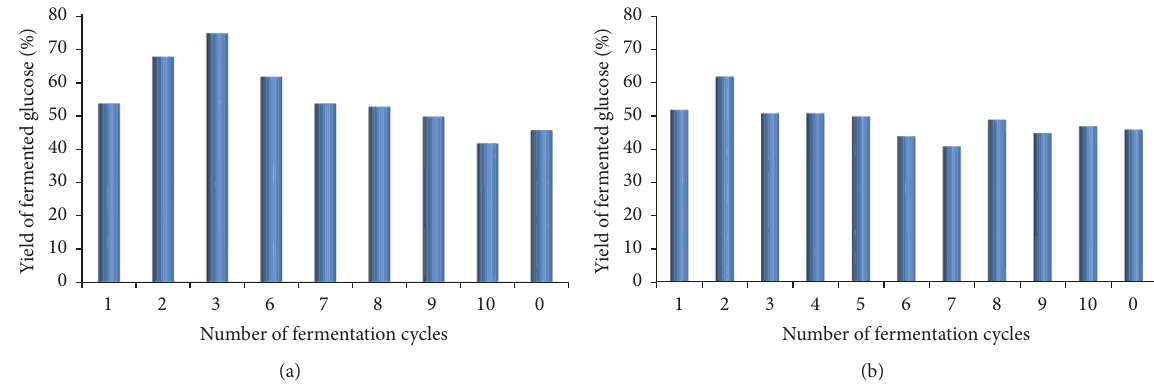
Figure 7: Yield values in fermented glucose (after 255 minutes) for the samples PD2 (a) and PD5 (b) as a function of the fermentation